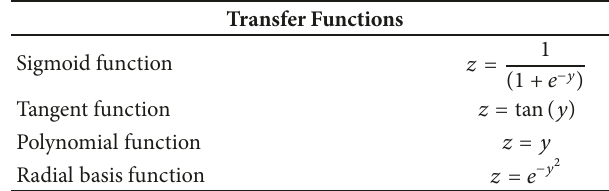
Table 1: Transfer functions of GMDH-NN